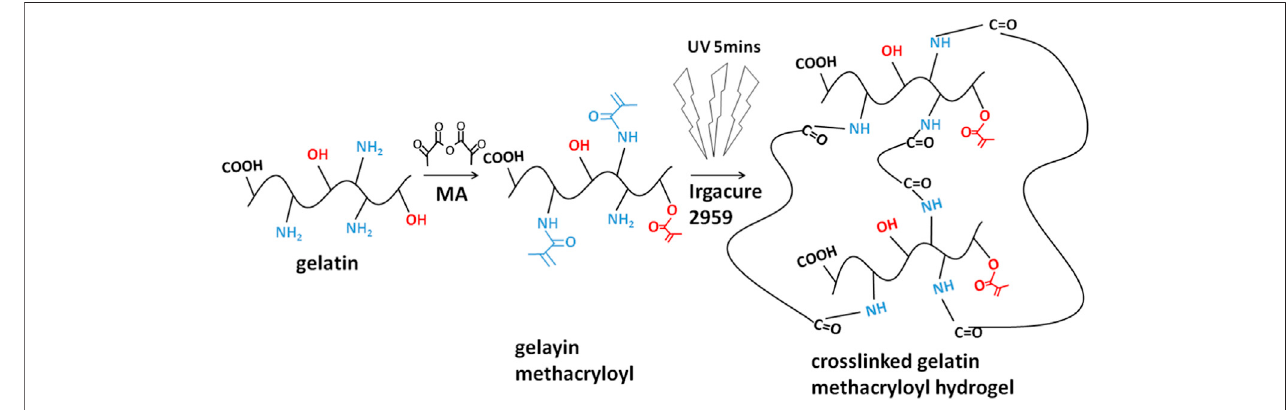
FIGURE 2 | The molecular formula of protein/peptide (gelatin) and MA-modi fi ed protein/peptide (GelMA).